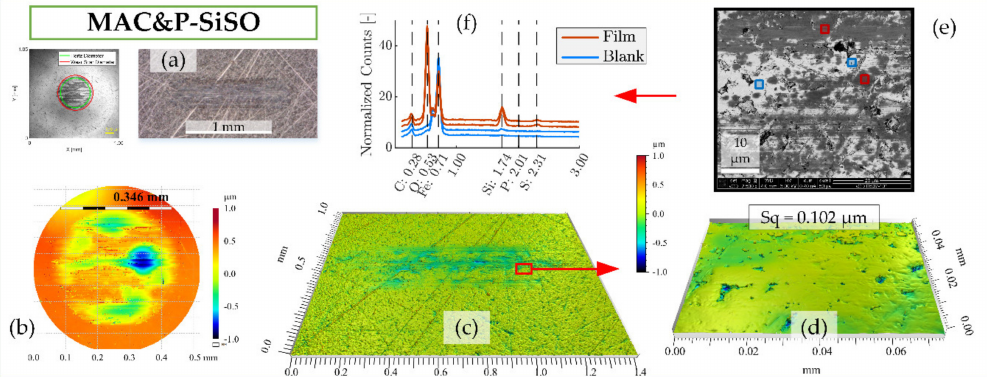
Figure 7. Surface analysis of SRV-3 steel samples lubricated with ‘MAC &P-SiSO’ under conditions {150 N/2.4 GPa/AIR}. ( a ) Overview of ball and disc wear scars. ( b ) Detailed view of ball wear scar topography as seen by 3DP with 10 × objective (curvature removed). ( c ) Disc wear scar topography seen by 3DP using 10 × objective and ( d ) detail at 50 × objective. ( e ) SEM-EDS analysis of region corresponding to topography in ( d ). ( f ) EDS spectra of regions of interest.